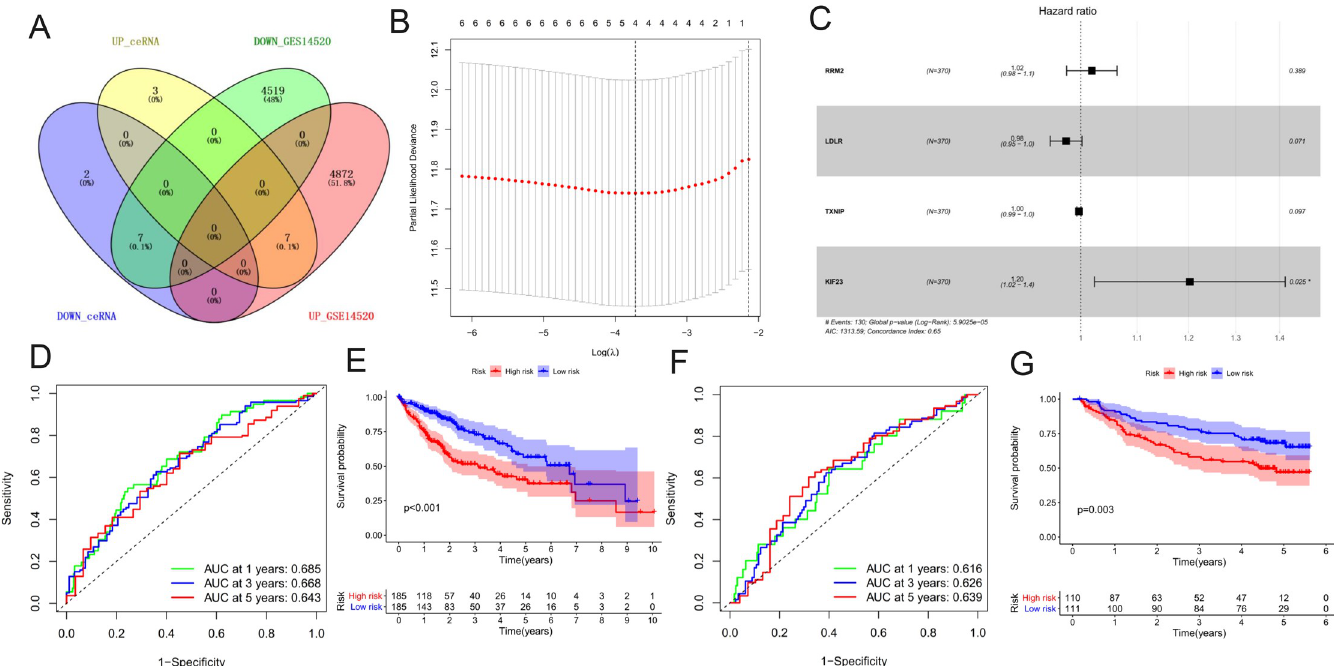
Fig 5. Identification and evaluation of the 19 mRNAs signature. (A) The 14 mRNAs used for the construction of the risk score model were produced by the intersection of DEGs in ceRNA and GSE14520. (B) Partial likelihood deviance of minimum number corresponds to the covariates revealed by the LASSO regression model. (C) Forest plots of hazard ratios (HR) of the four molecules with statistical differences OS-associated mRNAs. (D) The 1, 3, and 5 years of survival were analyzed by ROC curve to evaluate the efficiency of the clinical predictive model. (E) Survival curve of high and low-risk groups stratified by the prediction model. (F) The ROC curves of the external validation set GSE14520. (G) Survival curve of the external validation set GSE14520.